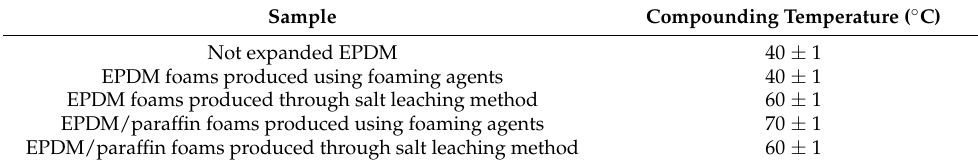
Table 2. Compounding temperatures used for the prepared samples.